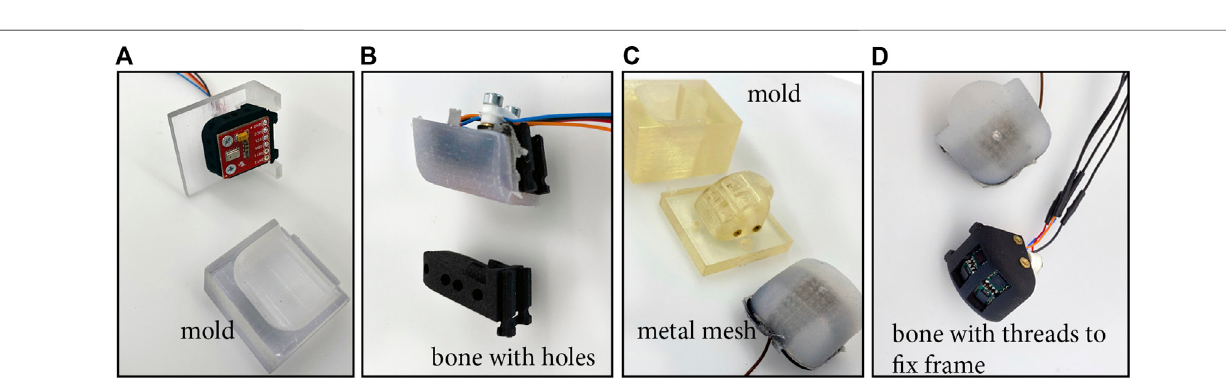
FIGURE 2 | Self-made tactile sensors: (A) casting mold for the pressure sensor (before casting); (B) casted pressure sensor and “ bone ” ( fi ngertip structure) with holes for simple sensors such as pressure sensors, IMU, or VL6180X; (C) casting mold and resulting silicone pad for the magnetic four-axis sensor; and (D) fi ngertip structure with four integrated MLX90393 sensor chips and silicone pad ready for